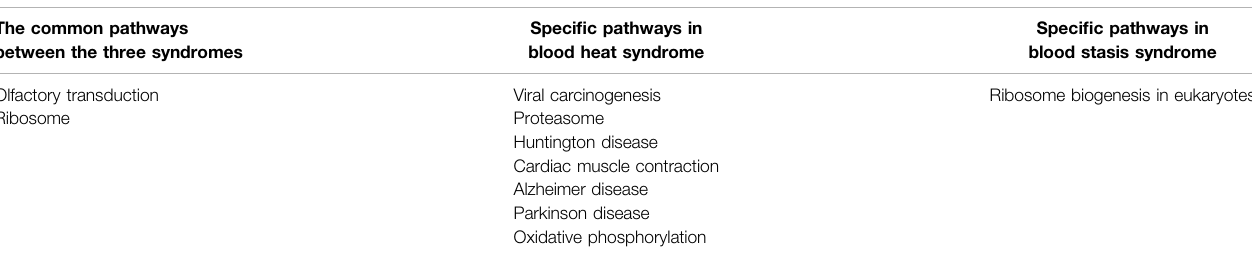
TABLE 2 | The common pathways and speci fi c pathways in different